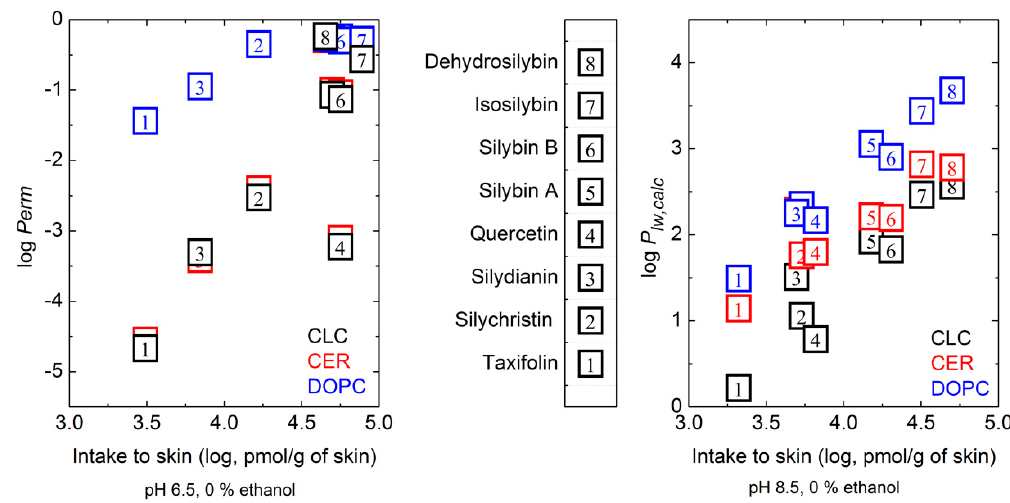
Figure 4. Relation between compounds’ skin intake and calculated permeability or partition coefficients in lipid membrane models. The relation between the logarithms of the compounds’ skin intake at pH 6.5 and calculated permeability (log Perm ) in lipid membrane models is presented on the left; the logarithms of the compounds’ skin intake at pH 8.5 and calculated lipid membrane models partition coefficients (log P lw,calc ) is shown on the right. CER—ceramide, DOPC—dioleoylphosphatidylcholine, CLC—ceramide, lignoceric acid and cholesterol mixture.